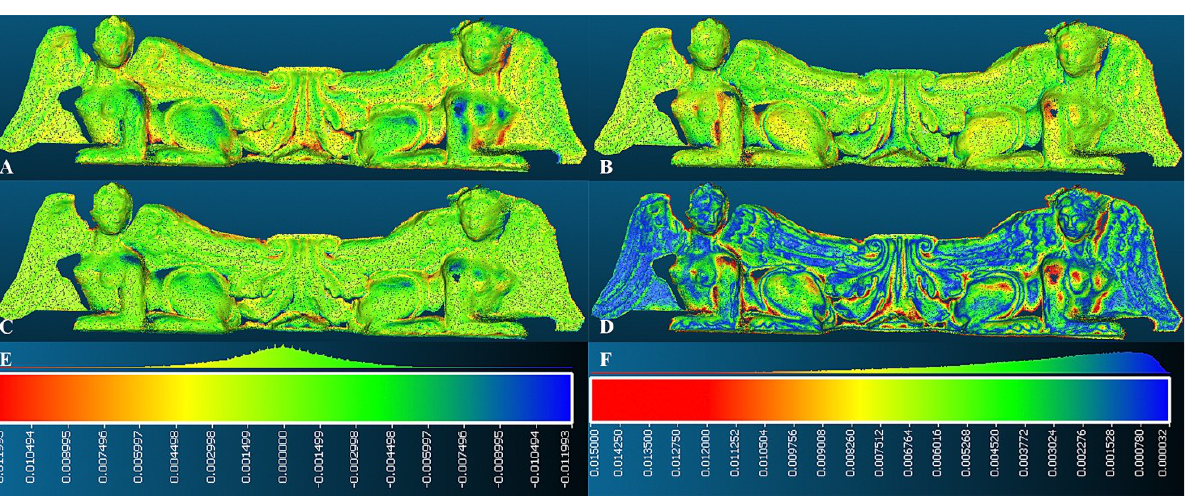
Figure 7. Map of MVS point deviation from a fitted plane for 4 analysed walls